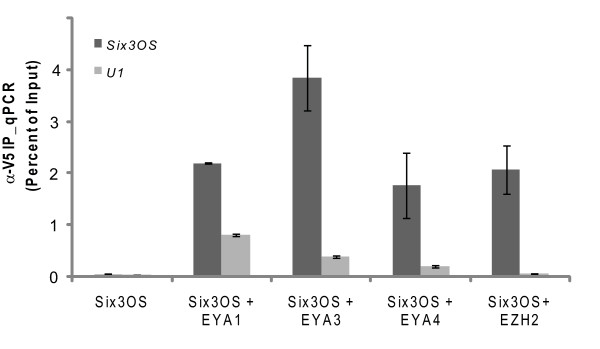
Six3OS-protein interactions detected via protein microarray. αV5-RIP specifically retrieves Eya1-V5, Eya3-V5, Eya4-V5 and Ezh2-V5 bound to Six3OS RNA but not U1 small nuclear RNA. Mean ± standard deviation, n = 3, relative to input is shown.